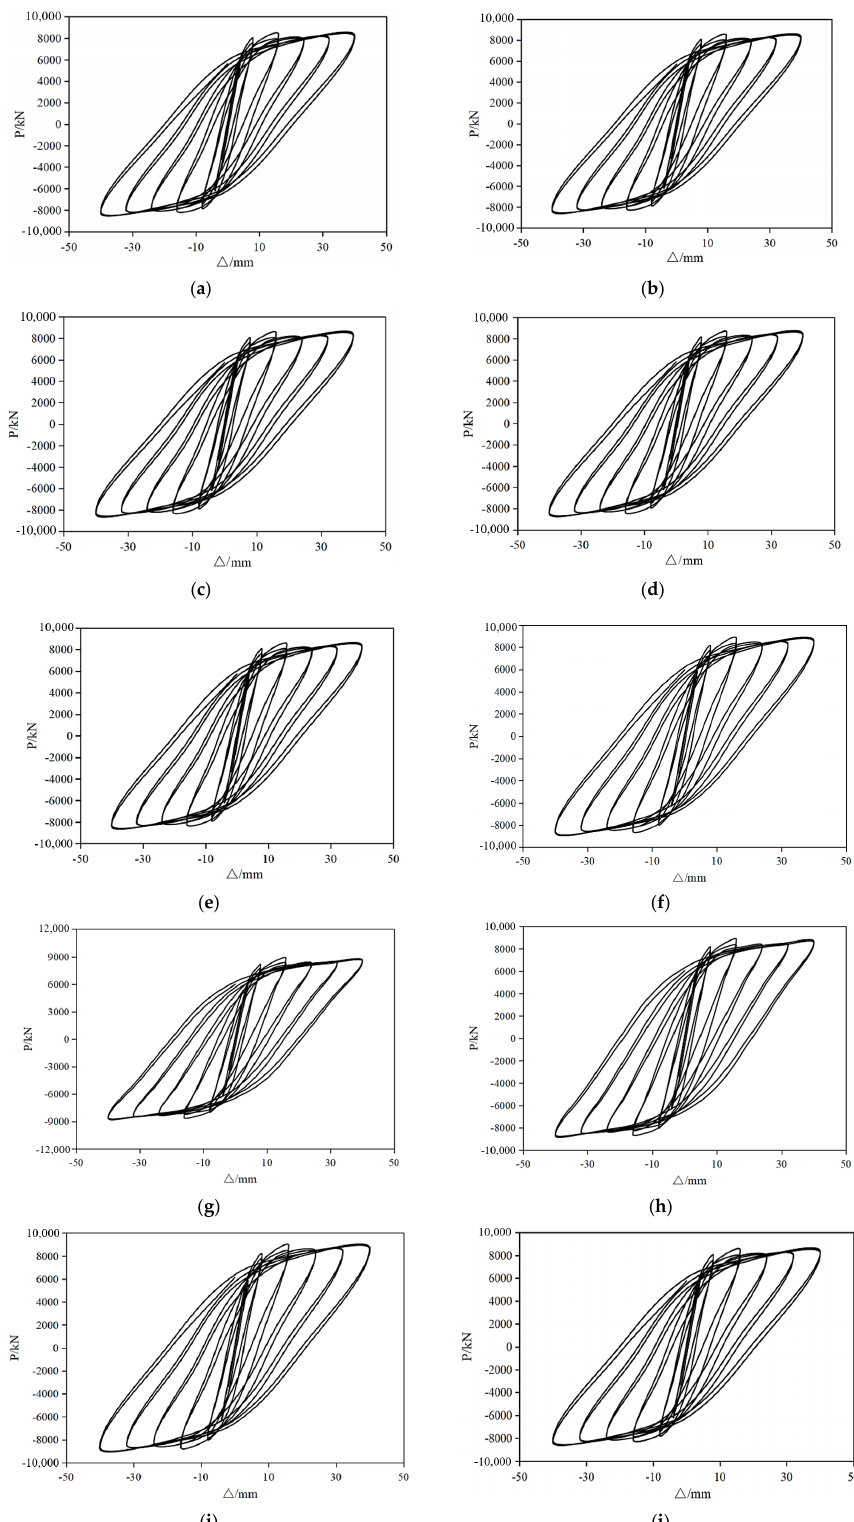
Figure 5. Hysteresis curve of models with different fishplate thicknesses. ( a ) t f = 4 mm; ( b ) t f = 5 mm; ( c ) t f = 6 mm; ( d ) t f = 8 mm; ( e ) t f = 10 mm; ( f ) t f = 12 mm; ( g ) t f = 14 mm; ( h ) t f = 16 mm; ( i ) t f = 18 mm; ( j ) GBSW-12.